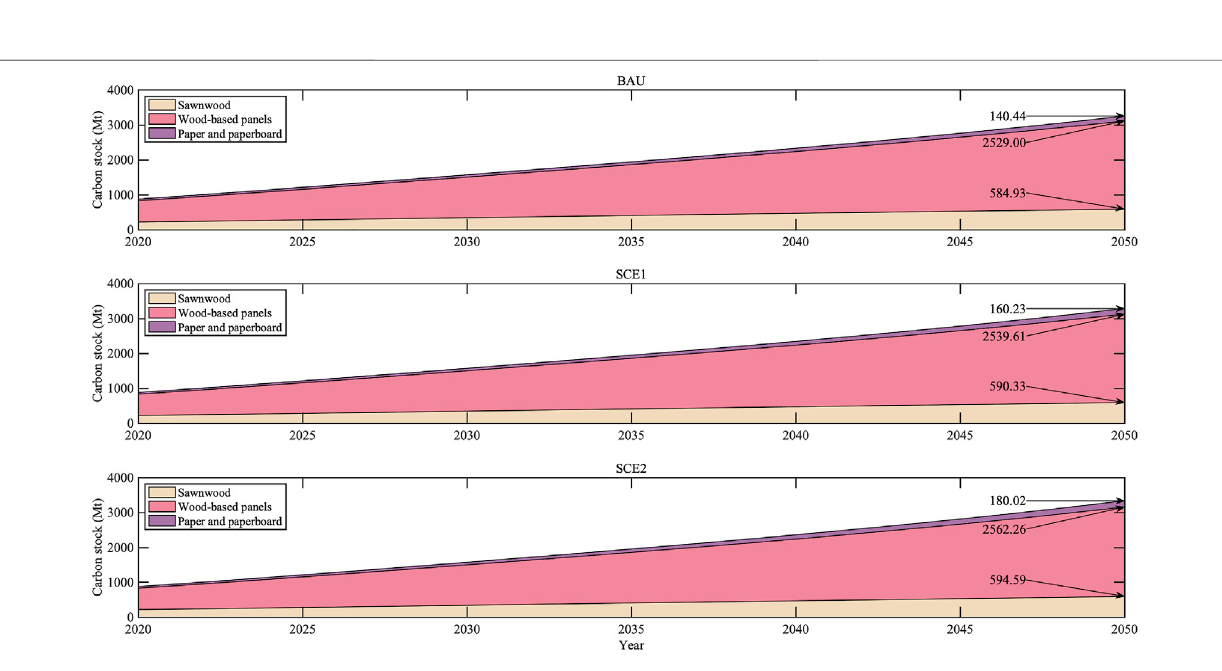
Frontiers in Environmental Science |